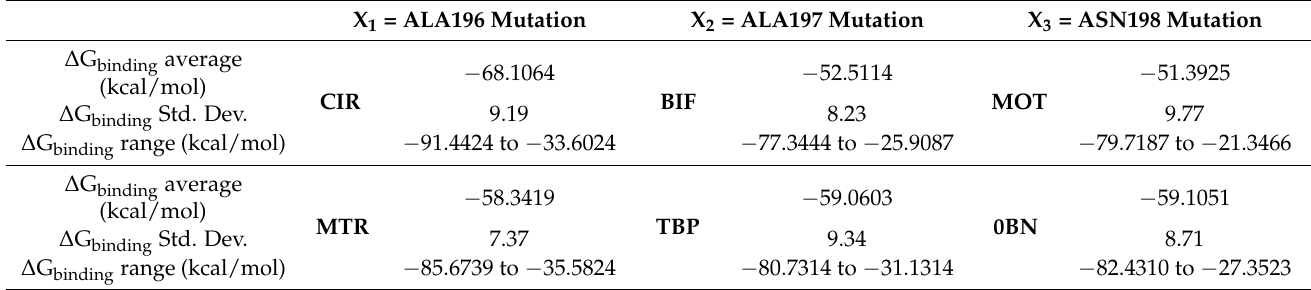
Table 4. Data results from MM-GBSA calculations of MD trajectories performed on point mutated HOXA9 peptides in complex with PBX1 and DNA X 1 = ALA196 Mutation X 2 = ALA197 Mutation X 3 = ASN198 Mutation Δ G binding average (kcal/mol) Δ G binding Std. Dev.